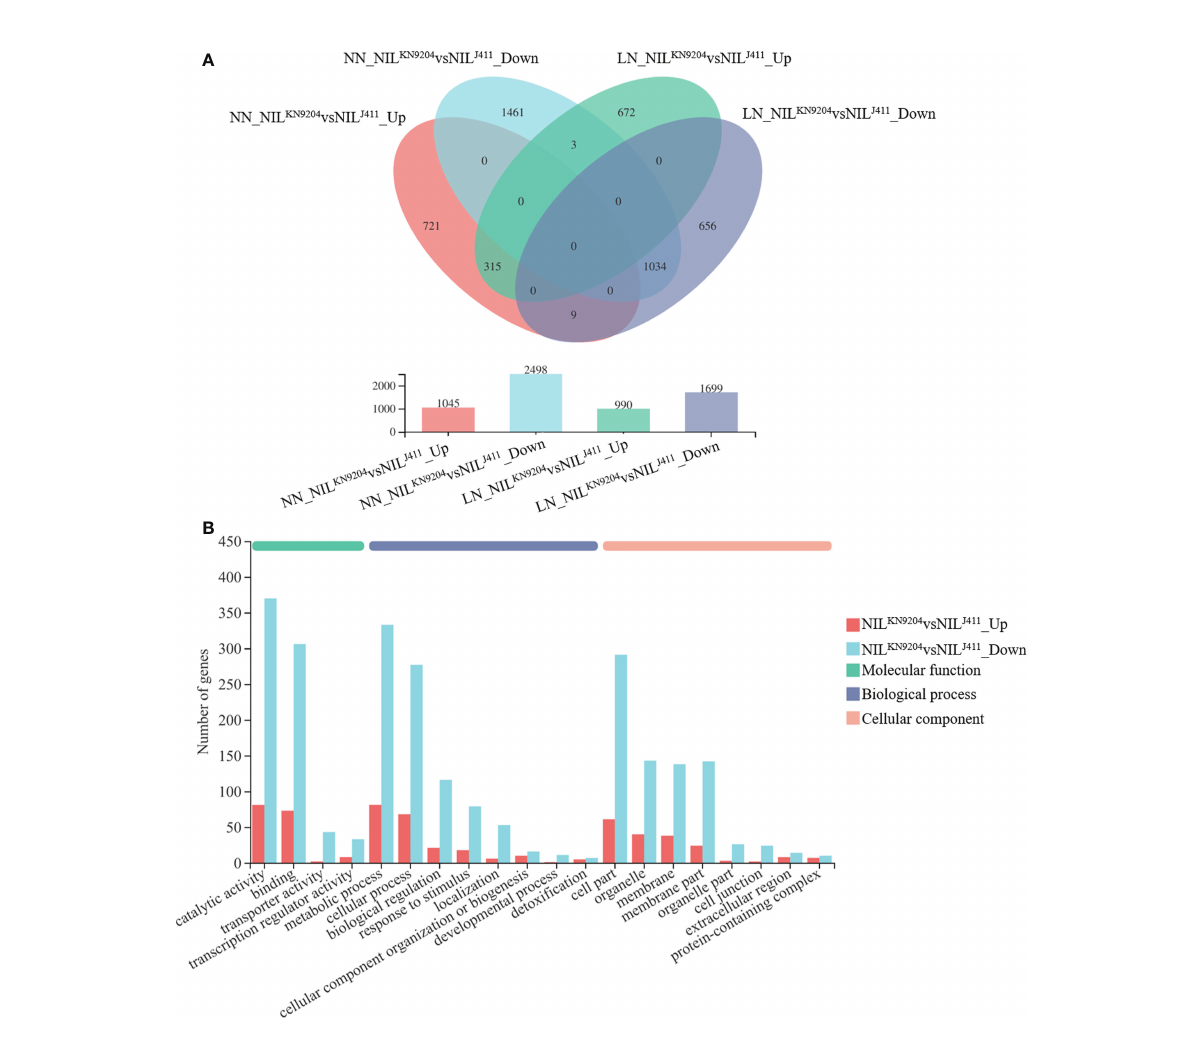
FIGURE 2 Identi fi cation of DEGs between the pairwise NILs NN and LN indicate normal- and low-nitrogen conditions, respectively. The expression levels between the NIL KN9204 and the NIL J411 were compared under each condition, with the former as a control. NIL J411 vs NIL KN9204 _Up and NIL J411 vs NIL KN9204 _Down indicate DEGs whose expression was upregulated and downregulated in the NIL J411 compared to the NIL KN9204 under the same culture conditions, respectively. (A) Venn diagram analysis of DEGs in each one-to-one comparison between the pairwise NILs under both NN and LN conditions. (B) GO annotation analysis of DEGs between the pairwise NILs that were simultaneously expressed under both NN and LN conditions with the fi rst 20 terms as